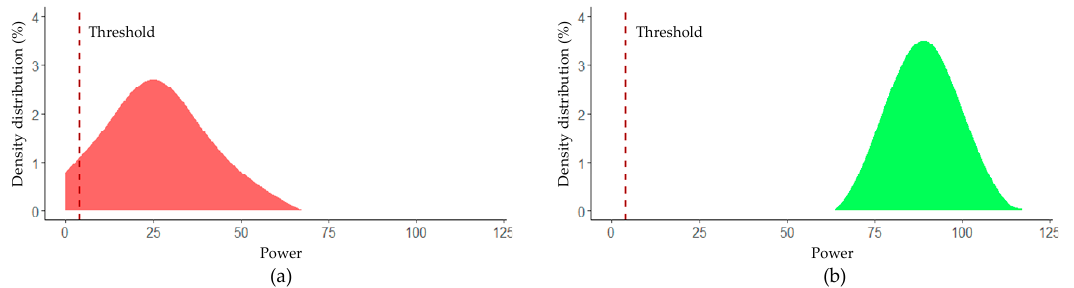
Figure 18. Statistical result diagram. ( a ) The density distribution of the system based on fiber; ( b ) The density distribution of the system based on artificial microstructures.